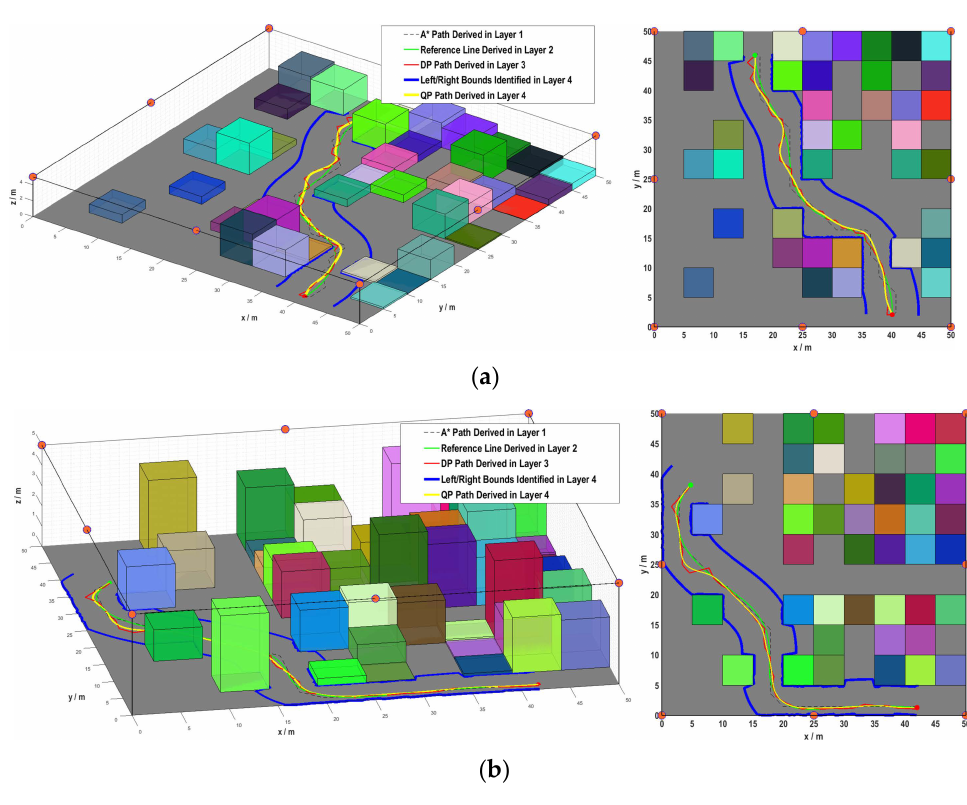
Figure 8. Path planning results of typical simulation cases in side view and bird-eye view: ( a ) Case 1; ( b ) Case 2 (zoom in to see more